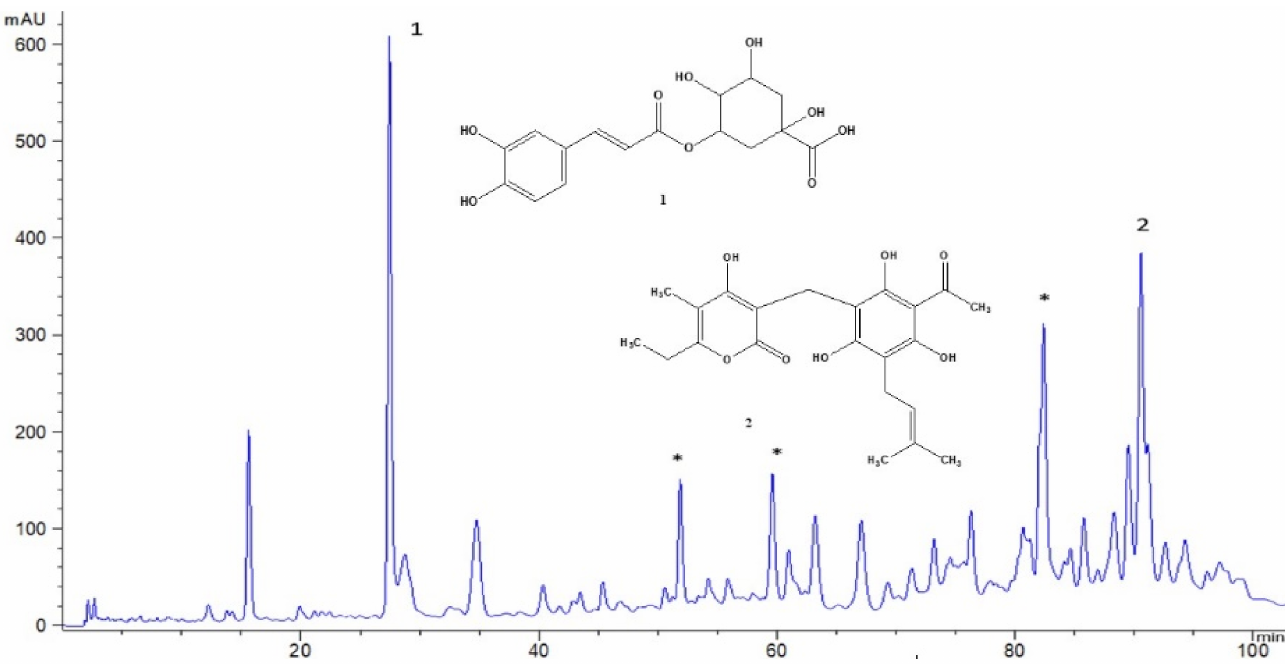
Figure 1. HPLC chromatogram of the immortelle SCO 2 extract used in the experiment, recorded at 280 nm: chlorogenic acid (1) and arzanol (2). *—phloroglucinol derivatives (gamma-pyrone